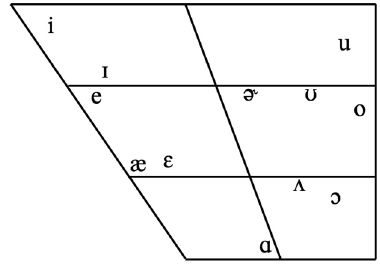
Figure 1. American English vowels in Northern Cities dialect regions according to Hillenbrand (2003).